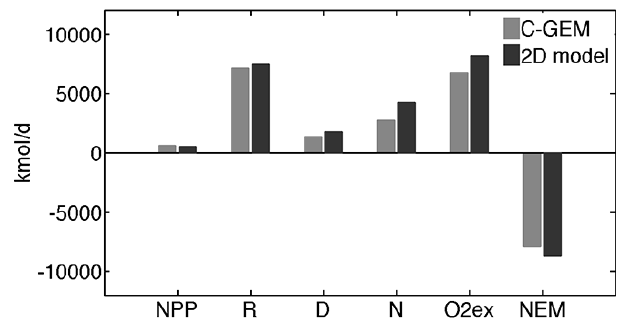
Figure 12. Comparison between system-integrated biogeochem- ical rates obtained by C-GEM and the 2D-RTM by Arndt et al. (2009). NPP = net primary production in kmolCd − 1 ; R = aerobic degradation in kmolCd − 1 ; D = denitrification in kmolCd − 1 ; N = nitrification in kmolNd − 1 ; O2ex = O 2 exchange at the air–water interface in kmolO 2 d − 1 ; NEM = net ecosystem metabolism in kmolCd − 1